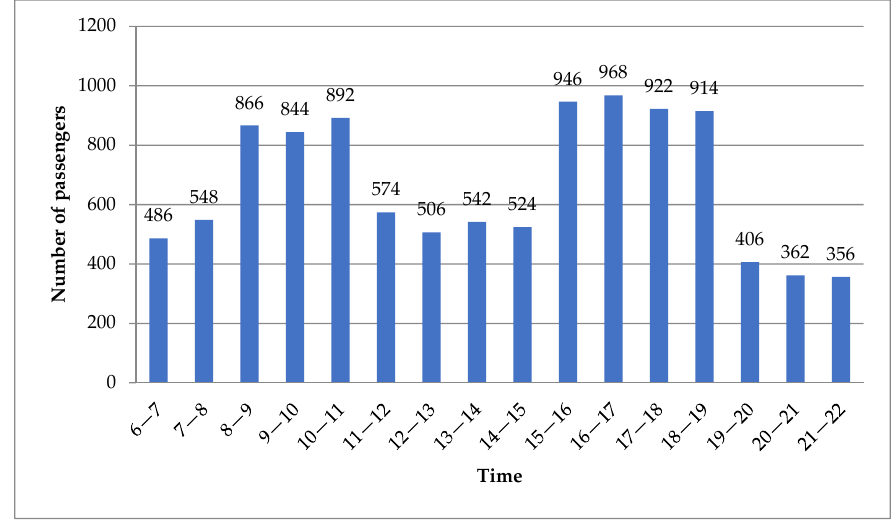
Figure 4. Passenger flow distribution in five periods.